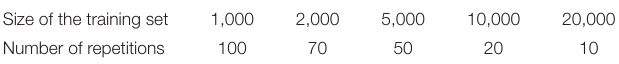
TABLE 3 | Number of repetitions for the evaluation of the predictive power on real data. Size of the training